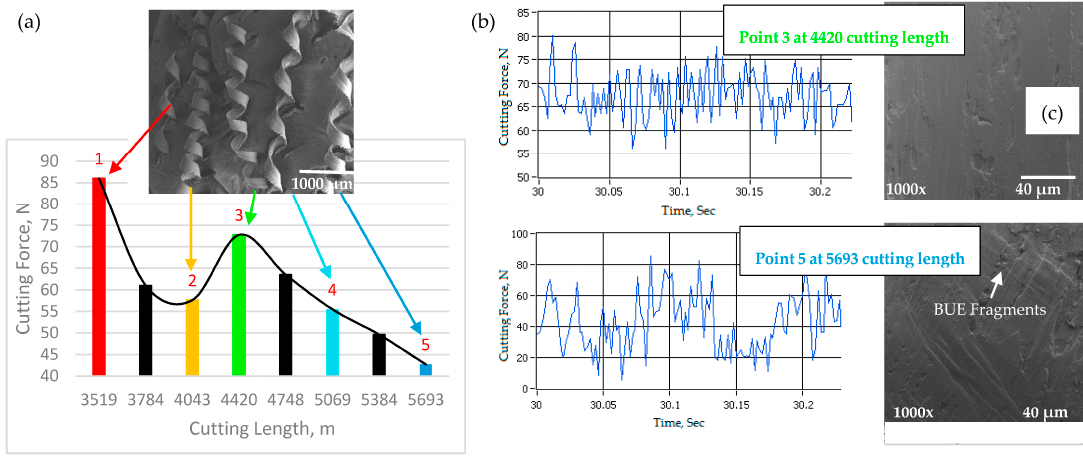
Figure 11. ( a ) Relation between cutting force and cutting length during steady state zone, combined with SEM image of chip formation: and ( b ) cutting force variations; and ( c ) chip undersurface for two selected points in Figure 13a. selected points in Figure